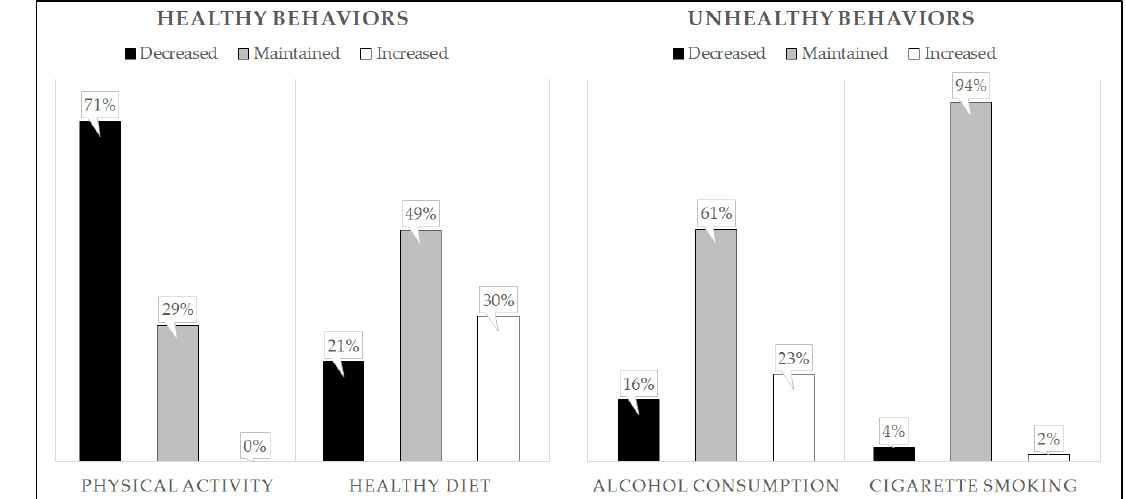
Figure 1. Percentage of participants who decreased, maintained, or increased their behavior con- cerning the four lifestyles between the prepandemic and pandemic period. A “decrease” in physical activity and a healthy diet indicates a worsening behavior, whereas a “decrease” in alcohol con- sumption and smoking indicates an improving behavior. An “ increase ” in physical activity and a healthy diet indicates improved behavior, whereas an “ increase ” in alcohol consumption and smok- ing indicates a worsening behavior.